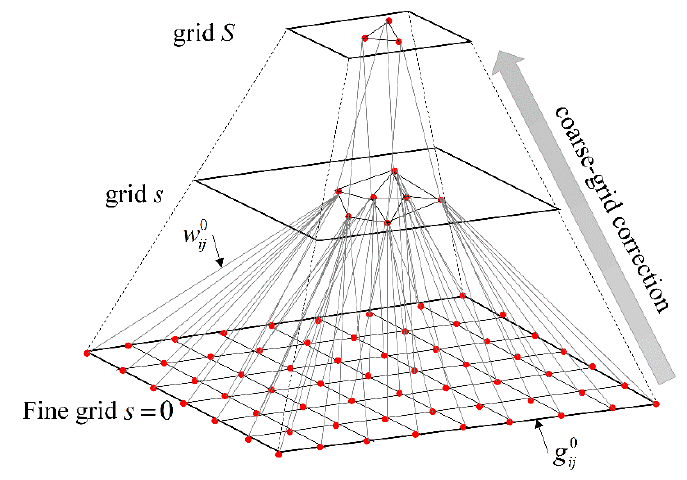
Figure 1. The multigrid structure of hyperspectral images (HSIs).